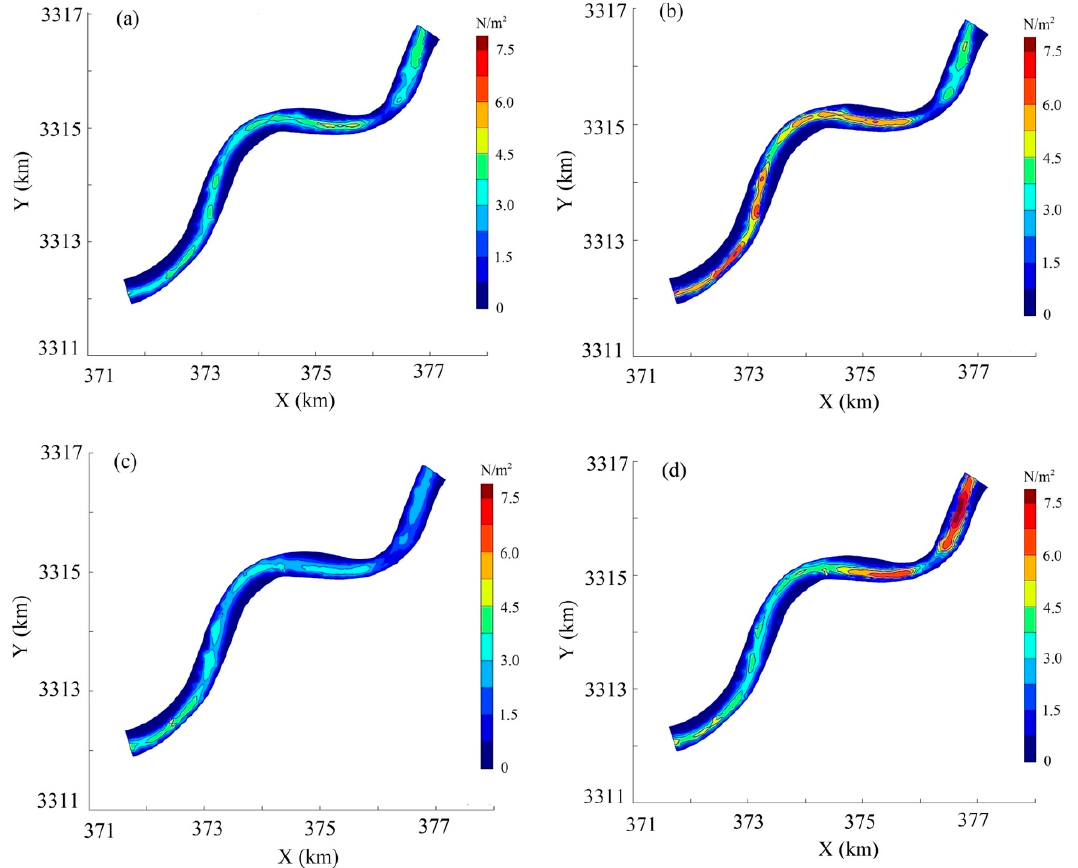
→ Figure 12. Distributions of τ b during the wet season (June 2015): ( a ) High tide; ( b ) Maximum ebb tide; Figure 12. Distributions of 𝜏 (cid:3029) (cid:4652)(cid:4652)(cid:4652)⃗ during the wet season (June 2015): ( a ) High tide; ( b ) Maximum ebb ( c ) Low tide; ( d ) Maximum flood tide; ( c ) Low tide; ( d ) Maximum flood tide. (1) 𝜏 (cid:3029) (cid:4652)(cid:4652)(cid:4652)⃗ is proportional to 𝑢 (cid:3029) (cid:4652)(cid:4652)(cid:4652)(cid:4652)⃗|𝑢 (cid:3029) (cid:4652)(cid:4652)(cid:4652)(cid:4652)⃗| and is also a function of H . In the meander reach, the |𝑢 (cid:3029) (cid:4652)(cid:4652)(cid:4652)(cid:4652)⃗| and H values are between 0.2 − 0.6 m/s and 6.0 − 14.0 m (exclusive of the scour hole at WL5). At the low and the high water, a similar 𝜏 (cid:3029) (cid:4652)(cid:4652)(cid:4652)⃗ distribution is exhibited (Figure 12a,c), with minor local discrepancy. 𝜏 (cid:3029) (cid:4652)(cid:4652)(cid:4652)⃗ reflects the velocity gradient, governed by the run-off and tides. At the maximum ebb and flood tides, the peak 𝜏 (cid:3029) (cid:4652)(cid:4652)(cid:4652)⃗ values are shown in Figure 12b,d.